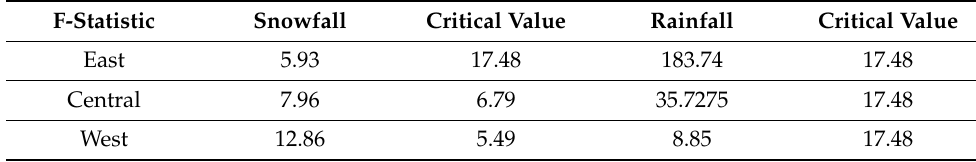
Table 1. Causal relationships of Himalaya Mode